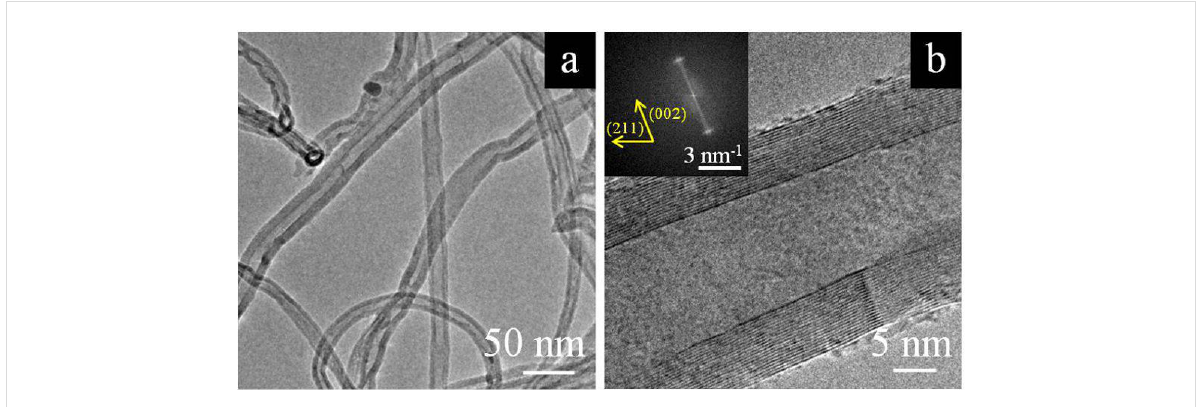
Figure 3: (a) Low-resolution TEM image assessing the multiwalled nature of the carbon nanotubes synthesized on SS. (b) High-resolution TEM picture of a single MWCNT with 19 walls. The inset displays the Fast Fourier Transform of the TEM image reported in (b). The two spots, at a semi- distance of 0.35 nm, represent the parallel walls.